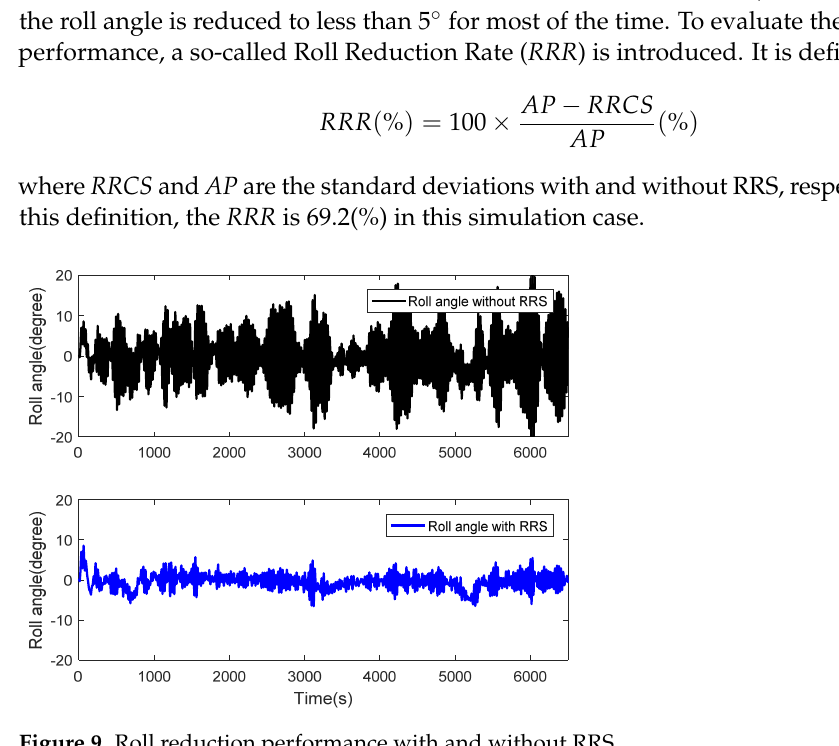
Figure 9. Roll reduction performance with and without RRS.